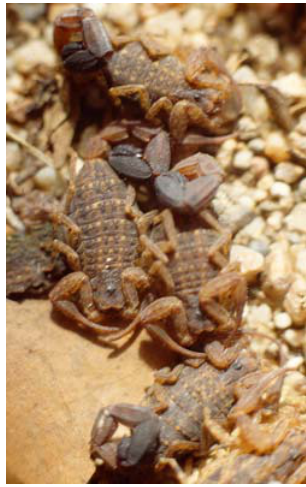
Figure 4. Tityus columbianus in a gregarious